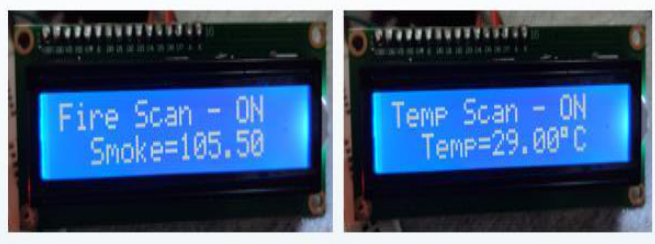
Figure 10: MQ5 is in ready mode and DHT11 in ready mode.